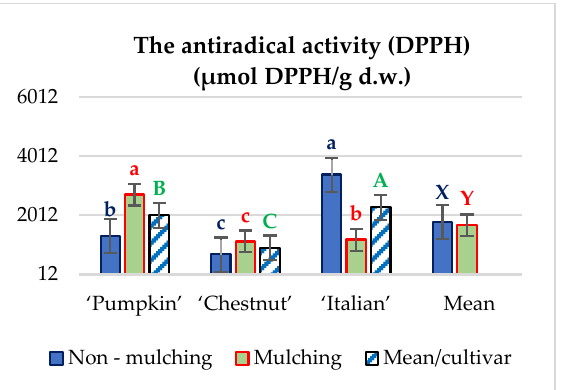
Figure 6. Total polyphenols in tuberous sweet potato roots (mg/GAE/g d.w.). Bars represent standard error. Means followed by same letter are not significantly different (Tukey’s multiple range test, p < 0.05).